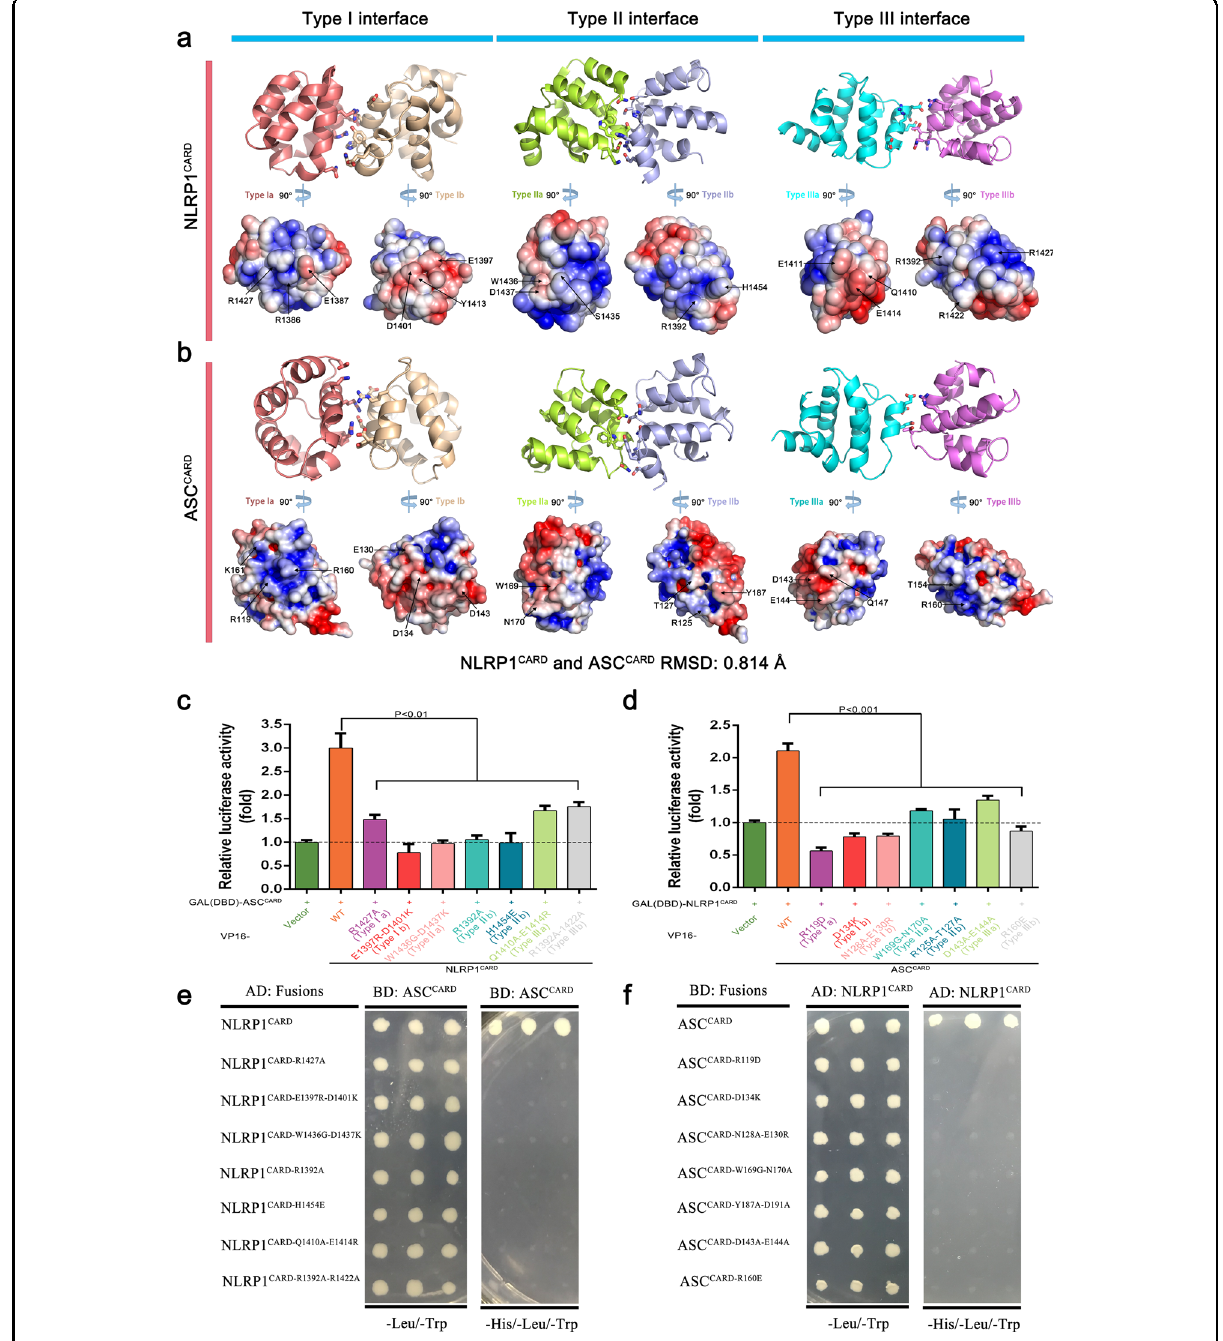
Fig. 4 NLRP1 CARD interacts with ASC CARD by three asymmetric interaction types of DD superfamily. a Model for Type I (deepsalmon and wheat), II (limon and lightblue), and III (cyan and violet) interface residues and electrostatic surface of NLRP1 CARD generated from the ASC CARD structure as template (PDB 6N1H). The key residues are shown and each of the colors represents the same interface type. b Structure for Type I (deepsalmon and wheat), II (limon and lightblue), and III (cyan and violet) interface residues and electrostatic surface of ASC CARD (PDB 6N1H). The key residues are shown and each of the colors represents the same interface type. c , e Measurement of the interaction between wild-type ASC CARD and NLRP1 CARD with different mutations by the M2H and Y2H experiments. Luciferase activity in the HEK293T cells was normalized to Renilla . The data were presented as the fold of negative control in c and ( − ) denotes empty vector control in e . Mean values ± SEM are representative of three independent experiments. d , f Measurement of the interaction between wild-type NLRP1 CARD and ASC CARD with different mutations by the M2H and Y2H experiments. Luciferase activity in the HEK293T cells was normalized to Renilla . The data were presented as the fold of negative control in d and ( − ) denotes empty vector control in f . Mean values ± SEM are representative of three independent